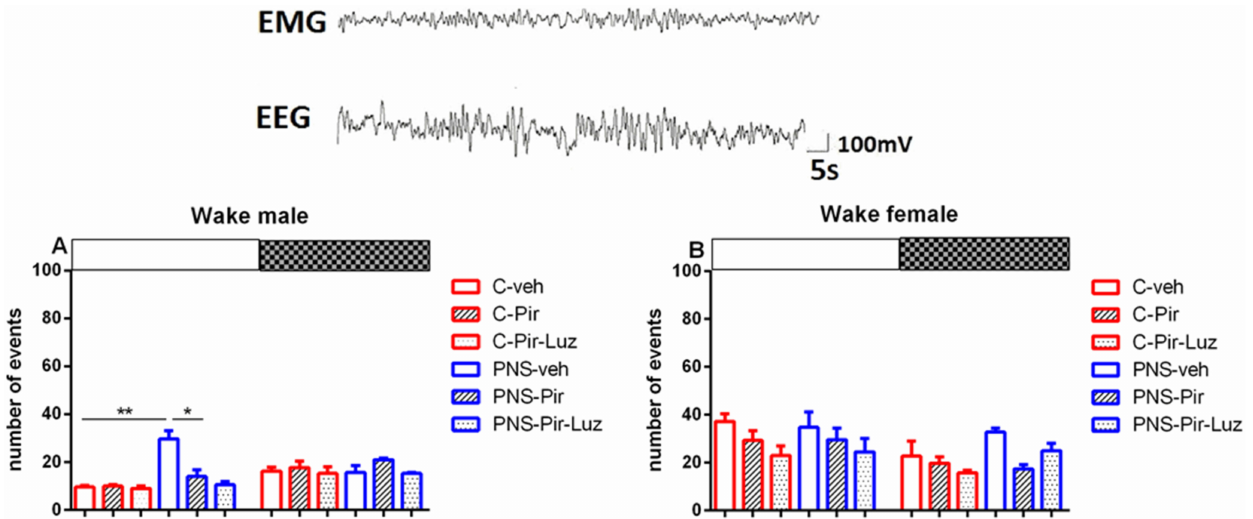
Figure 3. Representative EEG (frontal cortex) and EMG (neck muscle) recording during Wake of the control group. A high-pass filter was set at 0.5 Hz; low pass at 40 Hz. Calibration: 1 s, 100 mV. Diurnal rhythm of Wake number of events during the Light and the Dark phase, indicated by open and black rectangles above the figure, over a 24-h recording in male ( A ) and female rats ( B ) for C-veh, C-Pir, C-Pir-Luz, PNS-veh, PNS-Pir and PNS-Pir-Luz group. ** p < 0.01 vs. C-veh (Light phase); * p < 0.05 vs. PNS-veh (Light phase), respectively. Details as in Figure